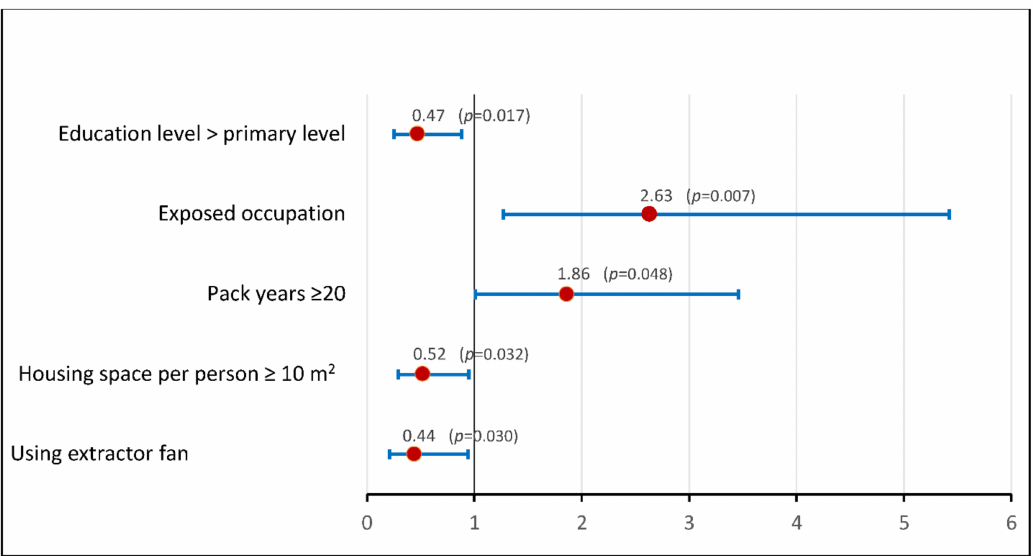
Figure 1. Modifiable factors related to exacerbation in asthma and chronic obstructive pulmonary disease. Horizontal bars indicate 95 percent confidence interval. Odds ratio is shown on the marker located on the horizontal